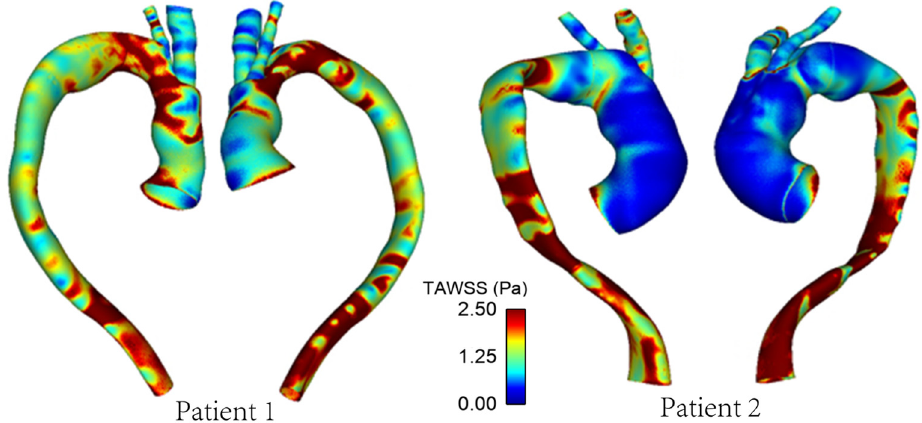
Figure 7. TAWSS distribution in the repaired aortas of Patients 1 and 2.